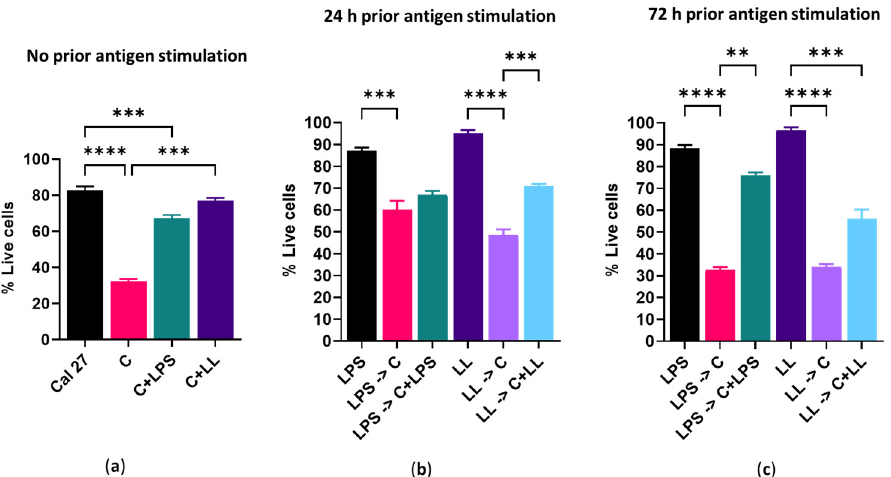
Figure 5. Effect of 150 µM/mL capsaicin on Cal 27 cell viability. Cal 27 cells were either with ( a ) no antigen pre-stimulation or ( b ) 24 h or ( c ) 72 h bacterial antigens pre-stimulation prior to the addition of inhibitory drugs. C = capsaicin, LPS = lipopolysaccharide, LL = LPS + LTA (lipoteichoic acid). Letter before the arrow represents pre-stimulation, e.g., LPS -> C is LPS pre-stimulation and then treatment with capsaicin (C). n = 9 biological replicates. Error bars represent standard error of the mean. ** p < 0.01, *** p < 0.001, **** p < 0.0001.